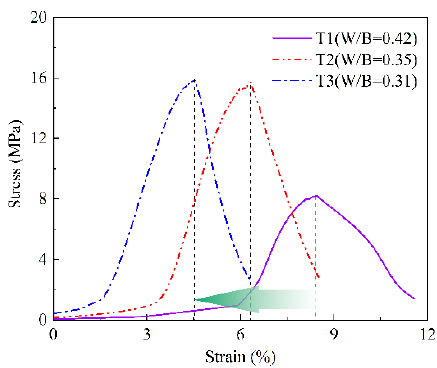
Figure 6. Stress-strain curves of mortars with different Water-to-Binder (W/B) ratios at 7 days.